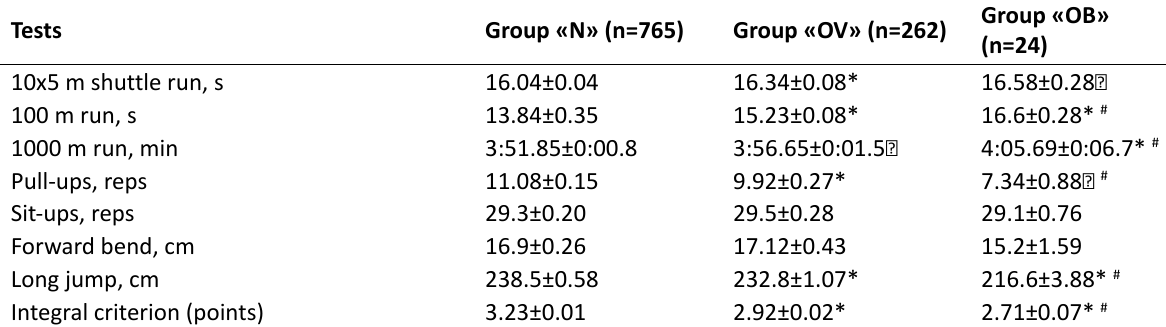
Table 4. The results of motor tests of males with different BMI means (M±SD)